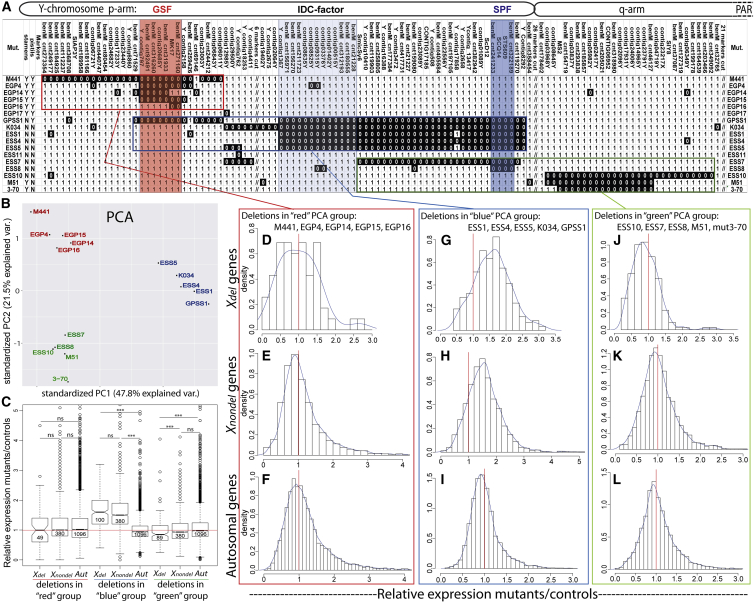
Upregulation of X-Linked Genes Is Caused by Deletions in the IDC-Factor Region of the P Arm of the Y Chromosome(A) Location of Y deletions in the mutants with sequenced transcriptomes (the full map is shown in Table S1). The presence and absence (deletion) of a marker in the particular mutant is indicated with 1 (white background) and 0 (black background), respectively. Note that 53 uninformative Y markers were excluded (marked with “//”) to make this figure narrower. Primers used for genotyping Y markers are listed in Table S2.(B) Clustering of mutants by relative expression in principle components analysis (PCA).(C–L) Boxplot comparing relative expression for the same categories of genes as shown in (D) to (L). The significance for these comparisons was tested with Wilcoxon rank sum test, ∗∗∗p < 0.001. The numbers of genes analyzed in each category are shown within the boxes on the boxplot. The box in this box-and-whisker plot (C) spans the first quartile (Q1) to the third quartile (Q3); the line inside the box shows the median; the notches represent the 95% confidence interval for the median; and whiskers show the range between Q1 − 1.5 × (Q3 − Q1) and Q3 + 1.5 × (Q3 − Q1). The red lines in (C) to (L) show the null expectation for no difference in expression between deletion mutants and controls. The blue curves in (D) to (L) show the kernel-smoothed density function for the distributions of relative expression in each category. To control for expression differences that could be caused by deletion of GSF or SPF loci and associated morphology changes, the hermaphroditic EGP mutants were normalized by expression in hermaphroditic mutant EGP17 that contained no big deletions and asexual ESS and K034 mutants were normalized by expression in asexual mutant ESS11 that also lacked big deletions, while q-arm mutants M51 and 3-70 that had a normal male phenotype were normalized by non-irradiated controls. The same analysis with all mutants normalized by non-irradiated controls is shown in Figure S2.Expression data used for these analyses are listed in Data S1. See also Figures S3 and S4 for related analyses testing whether upregulation of X-linked genes is caused by methylation changes or imprinting.